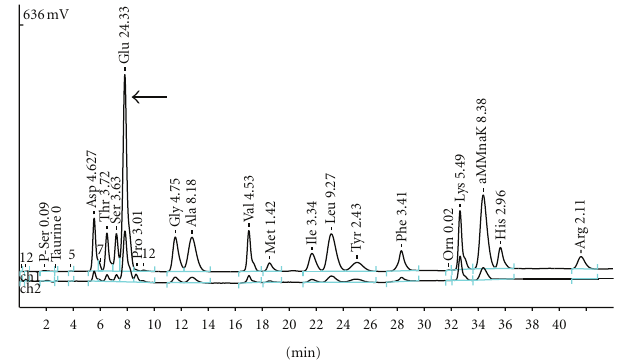
Figure 4: Elution profile of ApE1 hydrolysate. Arrow indicates the retention time of the glutamic acid.